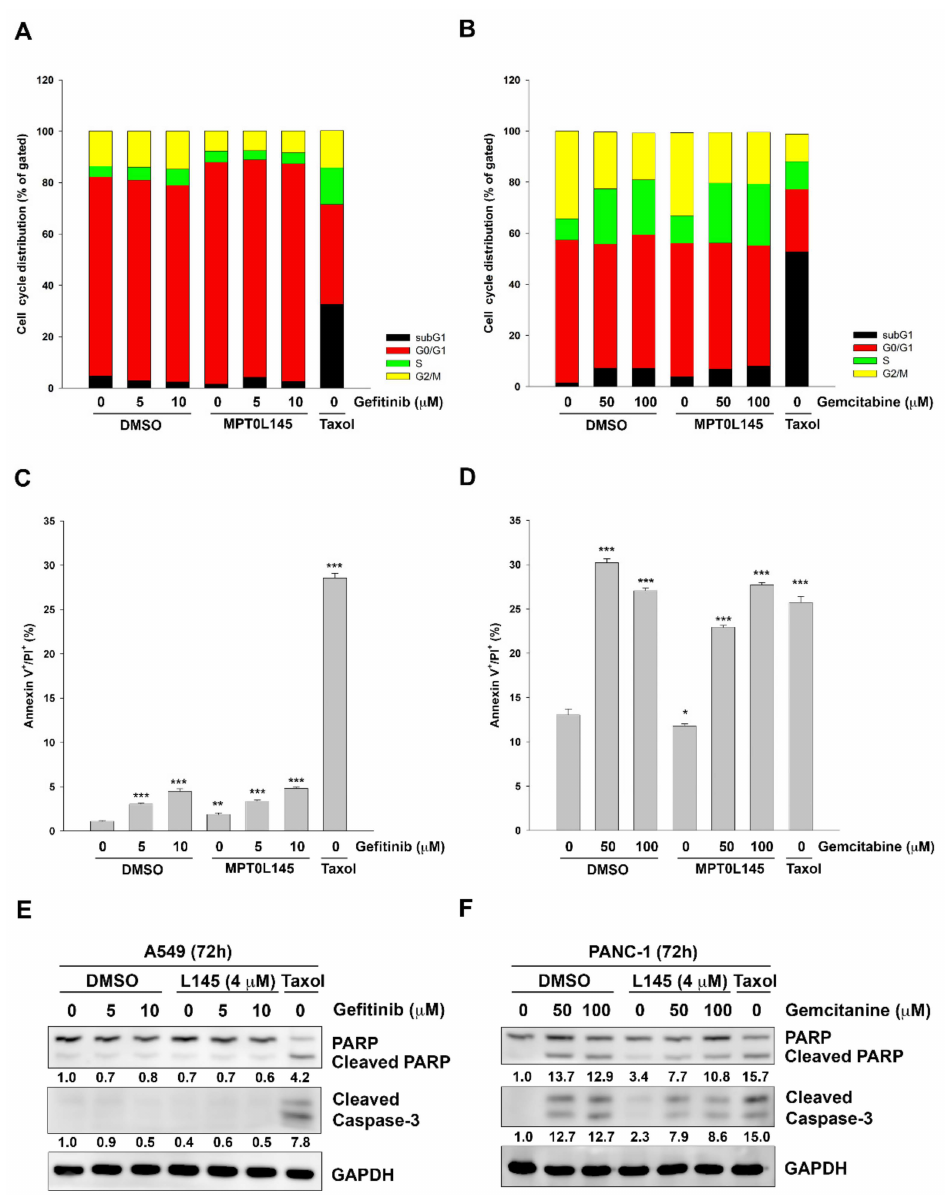
Figure 4. E ff ects of drug combination on cell cycle distribution and apoptosis. ( A , C ) A549 and ( B , D ) PANC-1 cells were respectively treated with MPT0L145 (4 µ M) in the presence of gefitinib or gemcitabine for 72h. The cells were then stained with propidium iodide solution ( A , B ) or Annexin V-FITC / PI solution ( C , D ) and analyzed by flow cytometry. Paclitaxel (Taxol, 0.1 µ M) was included as a positive control of apoptosis. ( E ) A549 and ( F ) PANC-1 cells were exposed to MPT0L145 (4 µ M) in the presence or absence of gefitinib or gemcitabine, respectively for 72h. The cells were subjected to western blot analysis by using antibodies against PARP, caspase-3 and